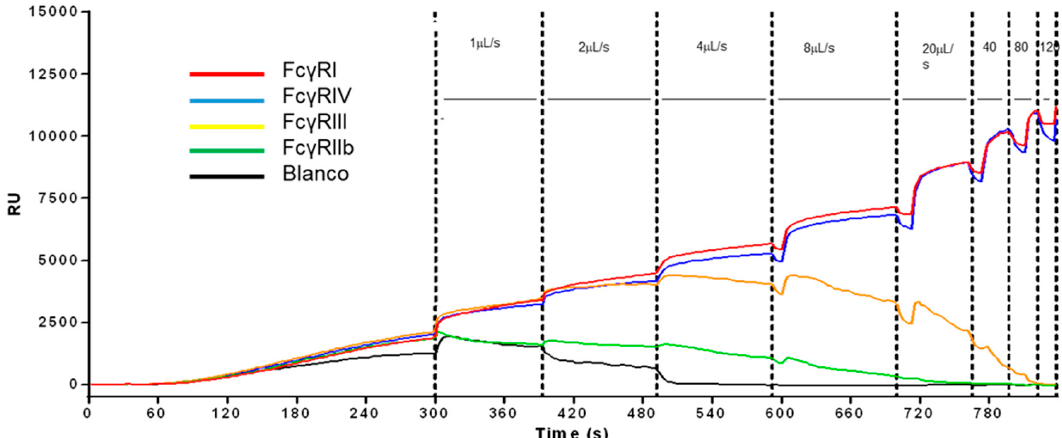
Figure 3. Affinity profiling using SPR. T/S sensorgram for label-free cell profiling measured in the IBIS MX96 (unpublished results). Red is Fc γ RI, blue is Fc γ RIV, orange is Fc γ RIII, green is Fc γ RIIb (all mouse), and black is blanco. Sedimented cells are subjected to an incremental increase in flow rate. When the drag forces of flow are too high, the cells will dissociate from the surface. RBCs will bind or dissociate dependent on the affinity and number of receptors (avidity). Increasing flow rate, stepwise (indicated by vertical dotted lines) from 1mL/s (at 300 s) up to 120mL/s, allows determining how well the cells bind to the spotted Fc γ Rs. Avidity was determined by measuring the binding strength of mouse IgG2a-opsonized RBCs to c-terminally biotin tagged Fc γ R on a streptavidin sensor measuring binding to all mouse Fc γ R simultaneously for each antibody (n = 6).